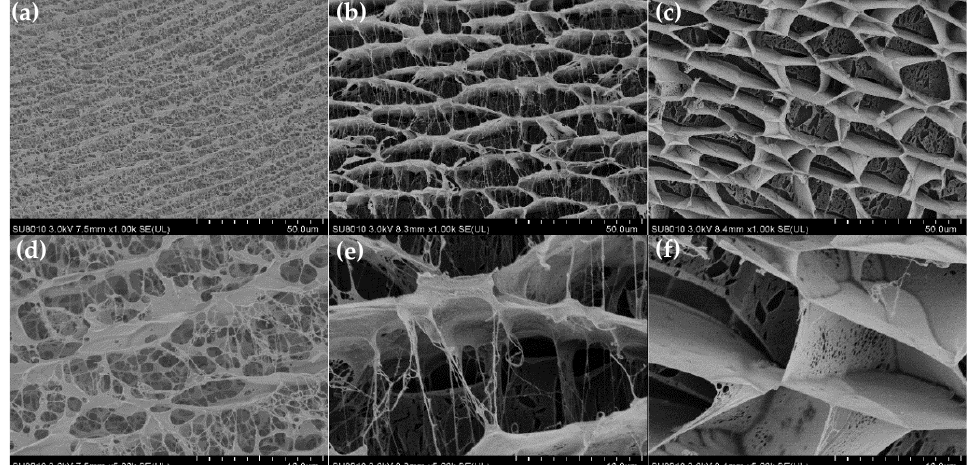
Figure 5. Cryo-SEM images of gels prepared with different polymers at different magnifications. ( a ) G3515 gel, ×1.00 k; ( b ) AM-AMPS25 gel, ×1.00 k; ( c ) AM-AMPS60 gel, ×1.00 k; ( d ) G3515 gel, ×5.00 k; ( e ) AM-AMPS25 gel, ×5.00 k; ( f ) AM-AMPS60 gel, ×5.00 k.